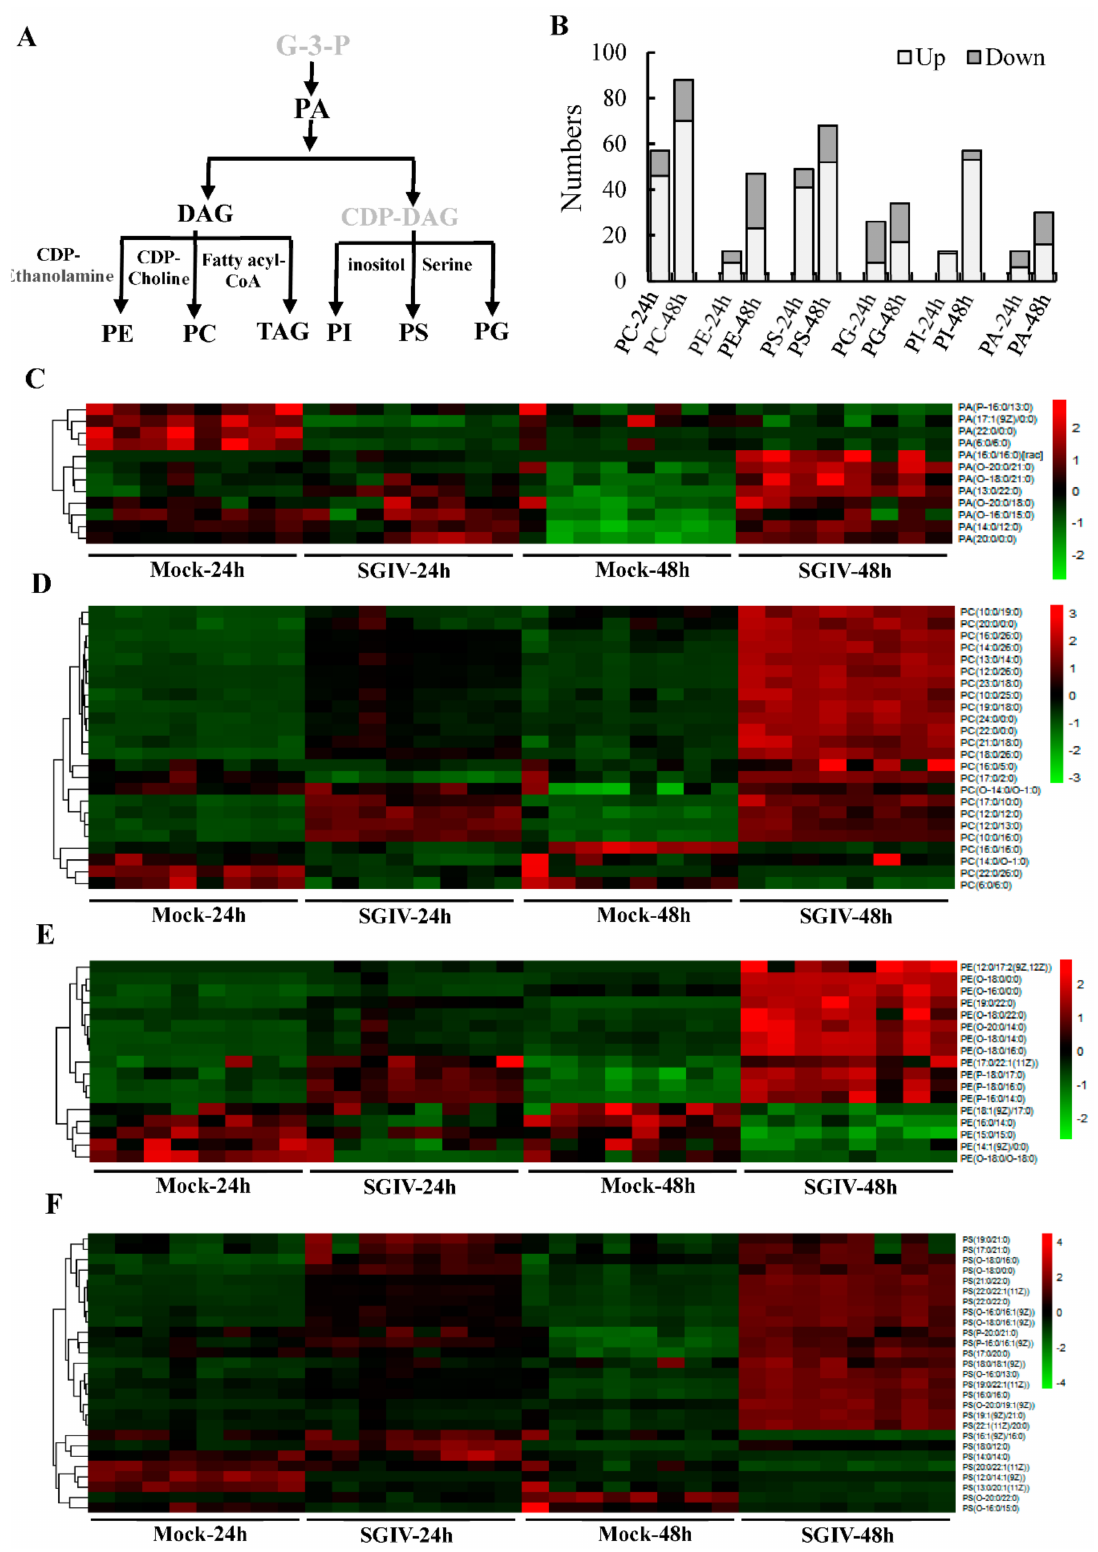
Figure 1. Lipidomic analysis of SGIV-infected cells showed a homeostatic change in glycerophospholipids (GPs). ( A ) The de novo biosynthetic pathways of GPs. ( B ) The number of lipid GPs subclasses detected in this study. ( C – F ) Heatmap of the differential changes of GP species, including phosphatidic acid (PA), phosphatidylcholine (PC), phosphatidylethanolamine (PE), phosphatidylserine (PS), which were all detected in SGIV-infected cells at 24 h and 48 h p.i. The heatmap generation was performed using the R package heatmap. Abbreviations: PG: glycerophosphoglycerol, PI: